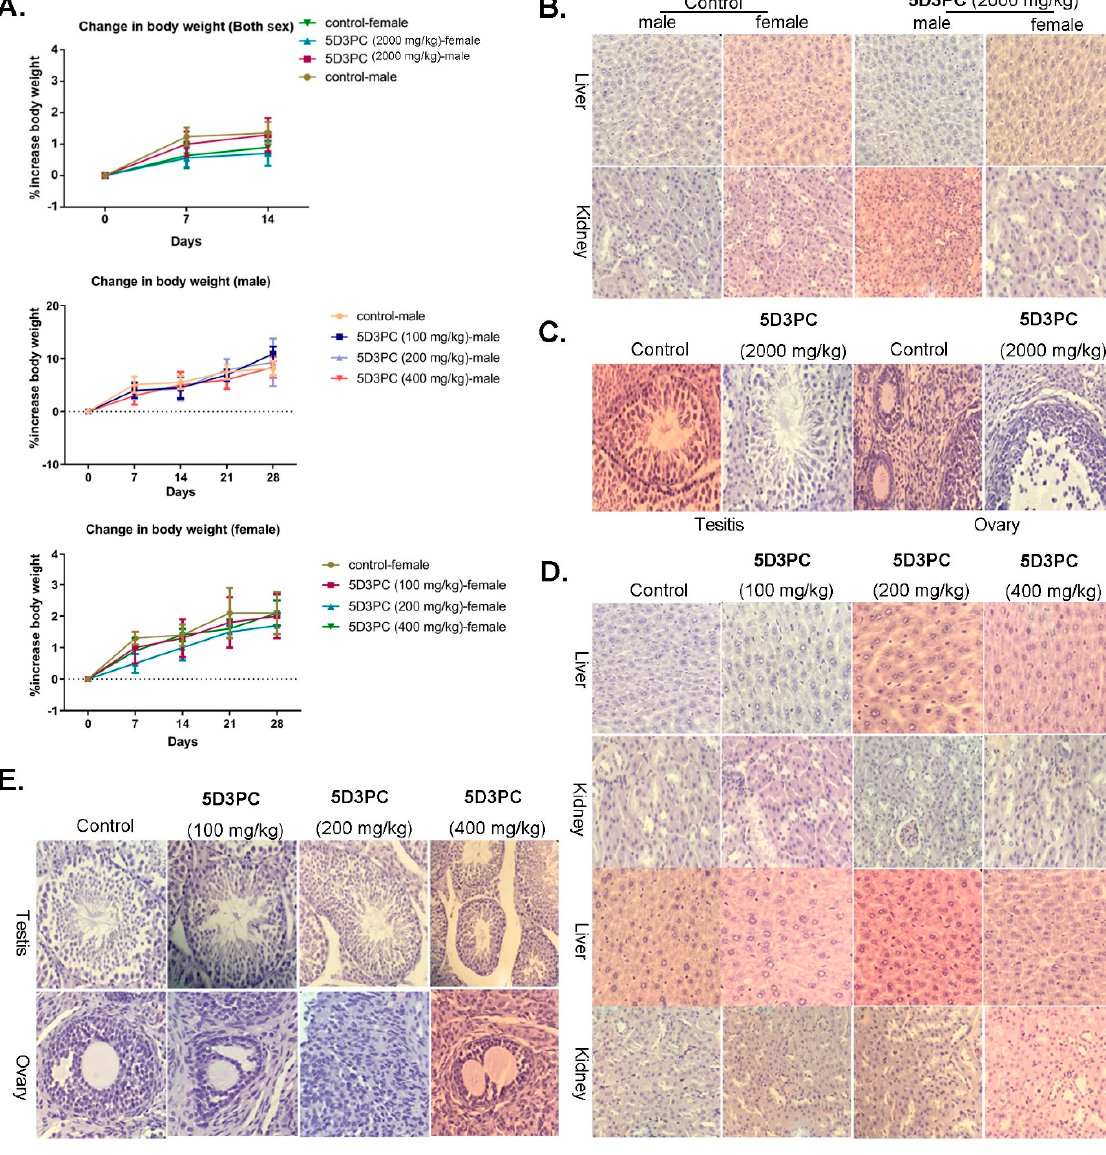
Figure 7. 5D3PC did not show acute or sub-acute toxicities. ( A ) Body weight of control and 5D3PC administered male and female mice. 5D3PC treatment has no major impact on body weights of acute study. ( B ) Photomicrography of liver, kidney, testis, and ovary of acute study. ( × 200, n = 2). ( C ) 5D3PC treatment has no major impact on body weights of sub-acute study. ( D ) Photomicrography of liver, kidney ( E ) testis, ovary in control and 5D3PC administration mice of acute and sub-acute study. ( × 200, n = 5). All results are expressed as mean ±